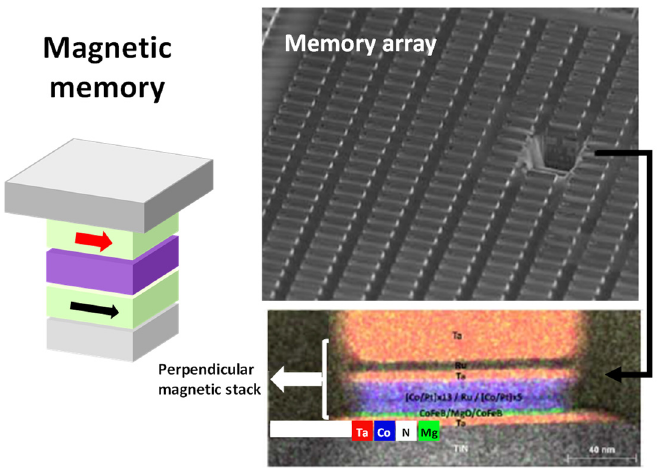
Figure 4. TEM cross-sections of perpendicular STT-MRAM integrated in a four kilobyte array in the BEOL of a 130 nm CMOS process, from [82].